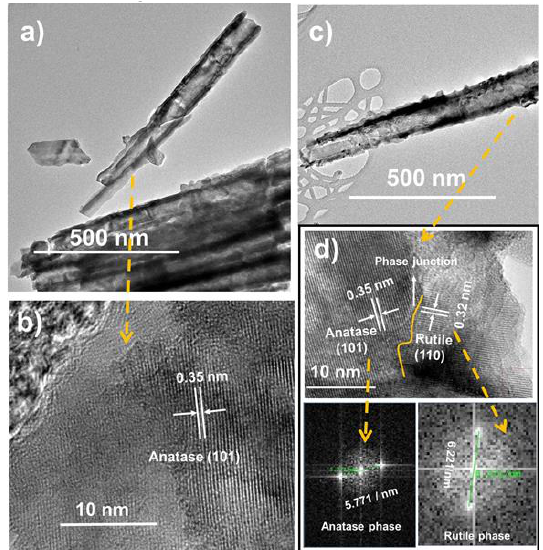
Figure 3. Transmission electron microscopy (TEM) ( a ) and high resolution (HR)-TEM images of TNT500 ( b ). ( c ) TEM image of TNT600. ( d ) HR-TEM image of TNT600 and corresponding FFT